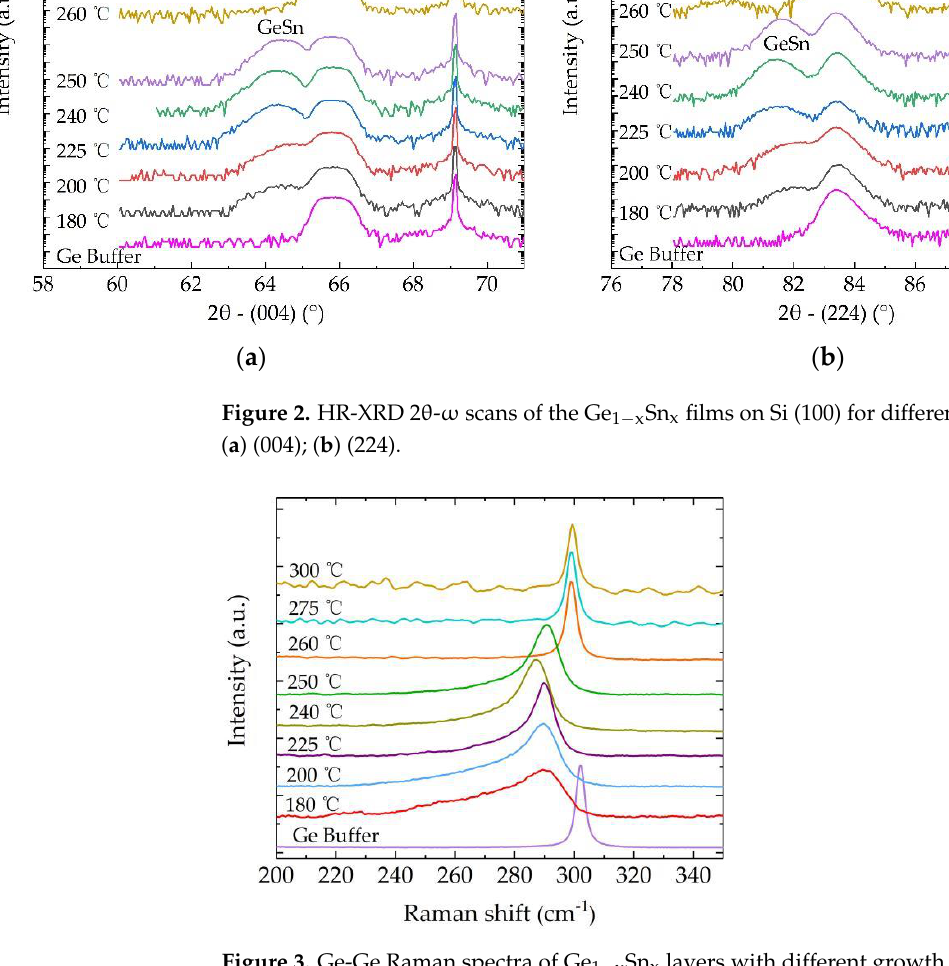
Figure 2. HR- XRD 2θ - ω scans of the Ge 1-x Sn x films on Si (100) for different deposited temperatures: ( a ) (004); ( b ) (224).